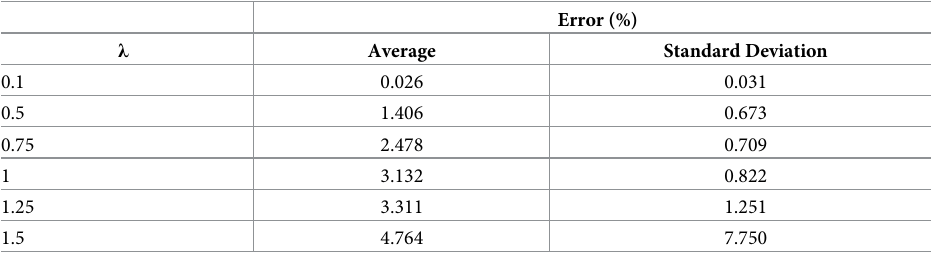
and β Classic Sim